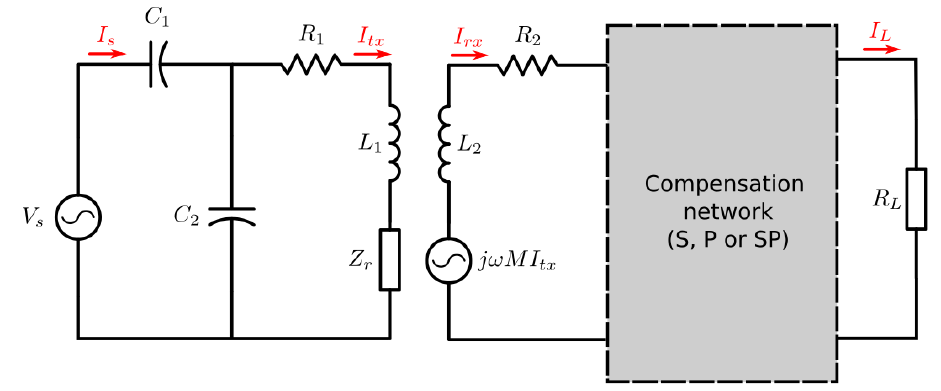
Figure 11. Transmitter and receiver complete circuit.